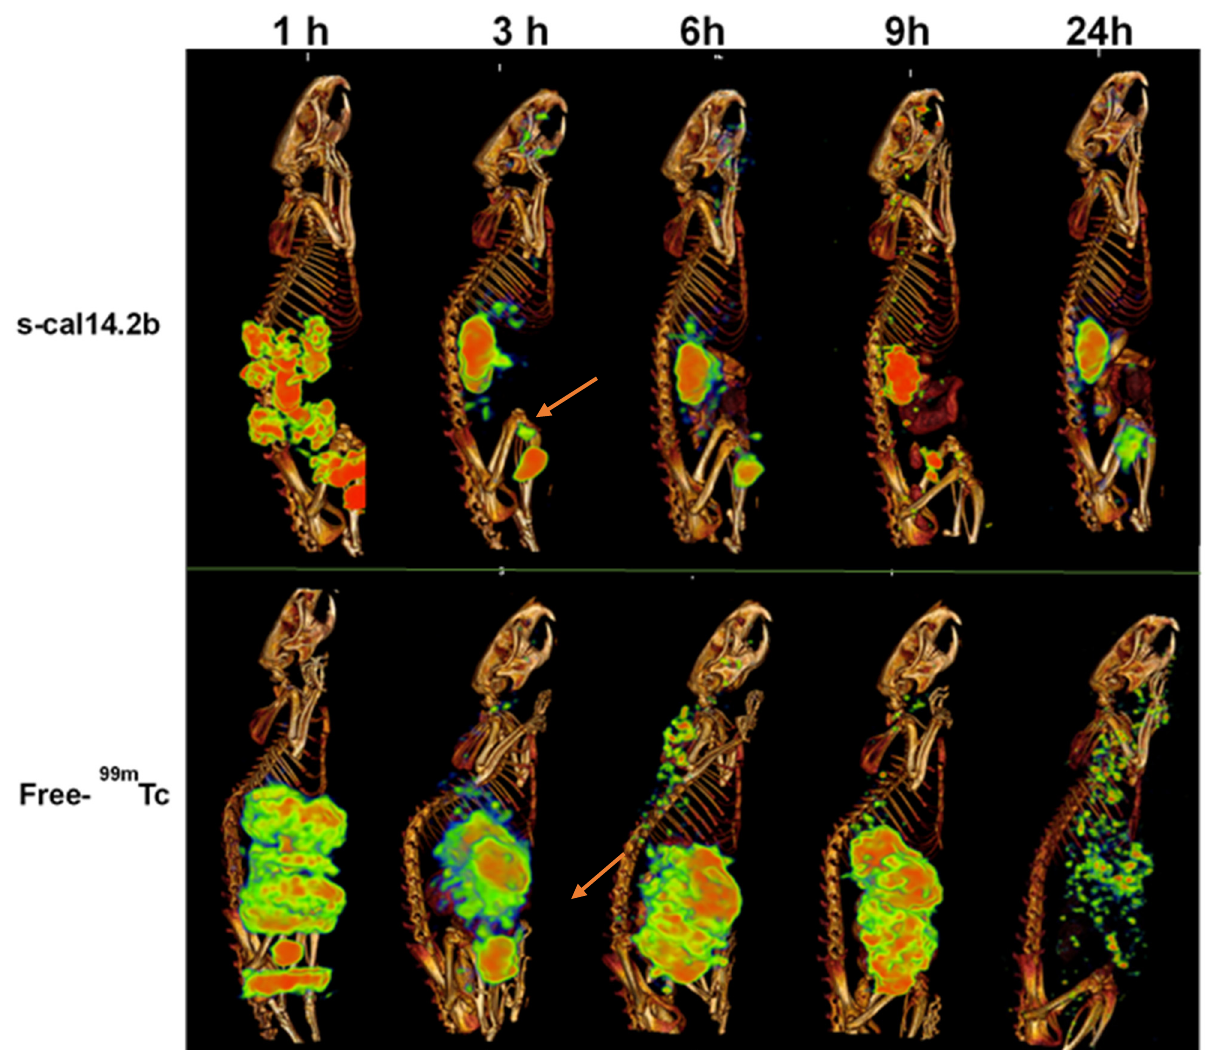
Figure 6. Biodistribution of radiolabeled s-cal14.2b in rats. The s-cal14.2b synthetic peptide was radiolabeled with 99mTc and administered to rats by intraperitoneal injection. The majority of 99mTc-s-cal14.2b was observed in peripancreatic and pancreatic regions (shown by arrows) with clearance most likely by renal excretion (even though s-cal14.2b was still detected 24 h after administration). Free 99mTc shows a different pattern of biodistribution and clearance by 24 h post administration.